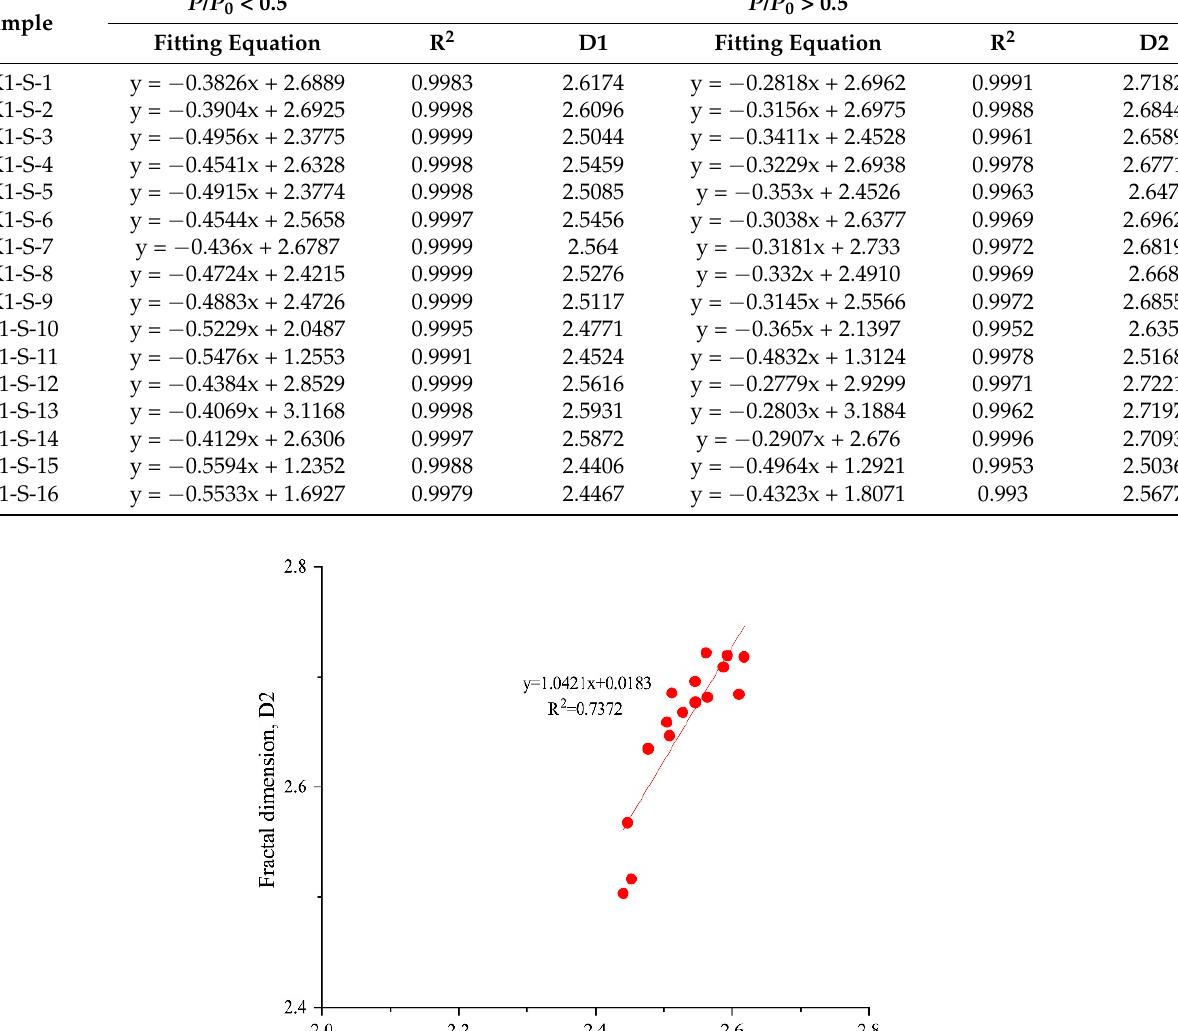
Table 5. Mineral composition of K 2 n 1+2 by XRD (unit: wt.%).